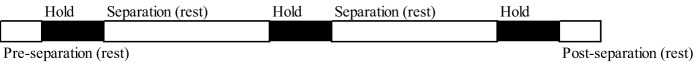
Procedure of separation of infant and parent.